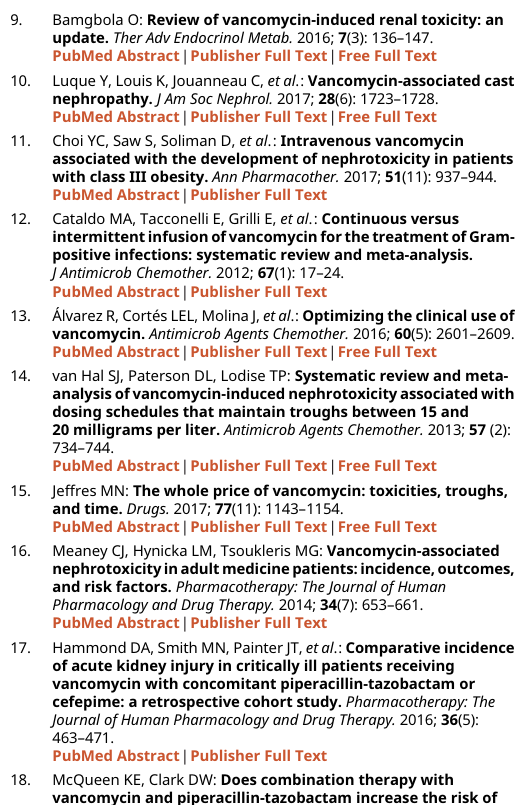
Figshare: CONSORT checklist for ‘ Impact of ascorbic acid in reducing the incidence of vancomycin associated nephro- toxicity in critically ill patients: A preliminary randomized controlled trial ’ , https://doi.org/10.6084/m9.figshare.15710004. v1. 28 Data are available under the terms of Creative Commons Zero “ No rights reserved ” data waiver (CC0 1.0 Public domain